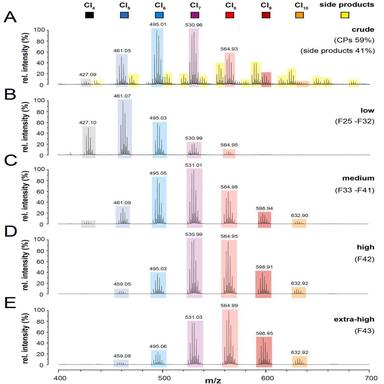
QToF-mass spectra of the crude synthesis product (A) and purified (B–E) C18-CP fractions of different average chlorination degrees. Chlorideadduct ions - of different CP homologues are highlighted in various colors. The crude material (A) contains various polychlorinated side-products (yellow). Purification of crude material was achieved by preparative normal-phase (silica) liquidchromatography with n-hexane/dichloromethane mixtures. CP-containing fractions were pooled to obtain four single-chain C18-CP-mat